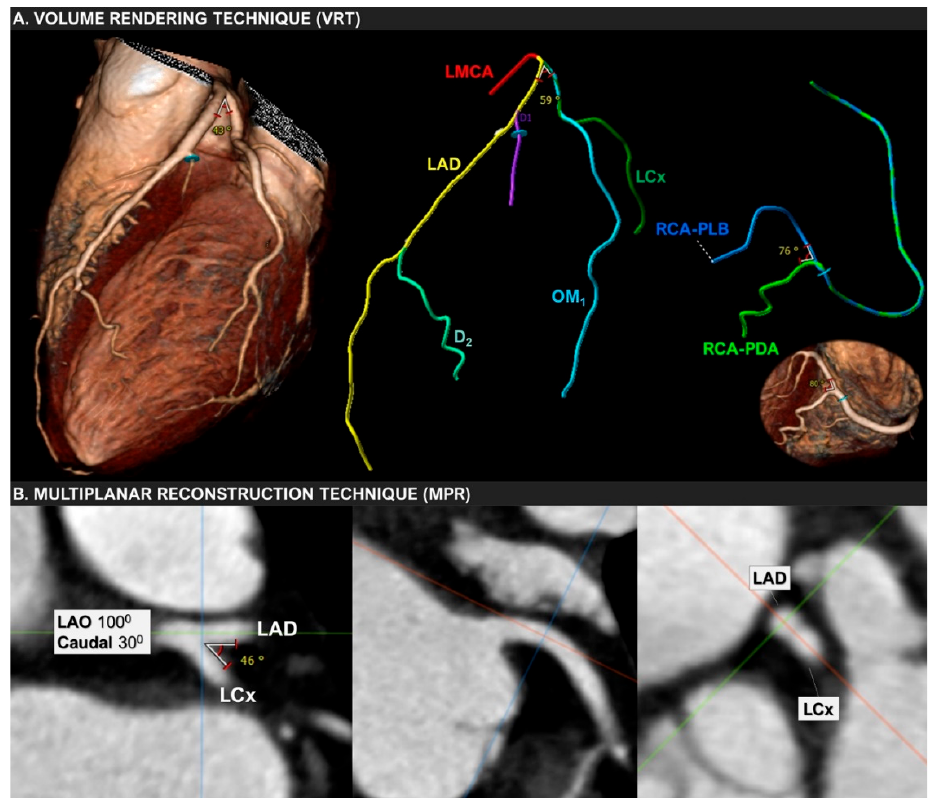
Figure 3. Volume ‐ rendering (VRT) and multiplanar reconstruction (MPR) techniques used to meas ‐ Figure 3. Volume-rendering (VRT) and multiplanar reconstruction (MPR) techniques used to measure ure the bifurcation angle between LAD and LCx in a 67 ‐ year ‐ old woman with mild non ‐ obstructive the bifurcation angle between LAD and LCx in a 67-year-old woman with mild non-obstructive coronary artery disease. coronary artery Table 1. Relationship between main geometric features proposed in the literature and atherosclero ‐ sis.